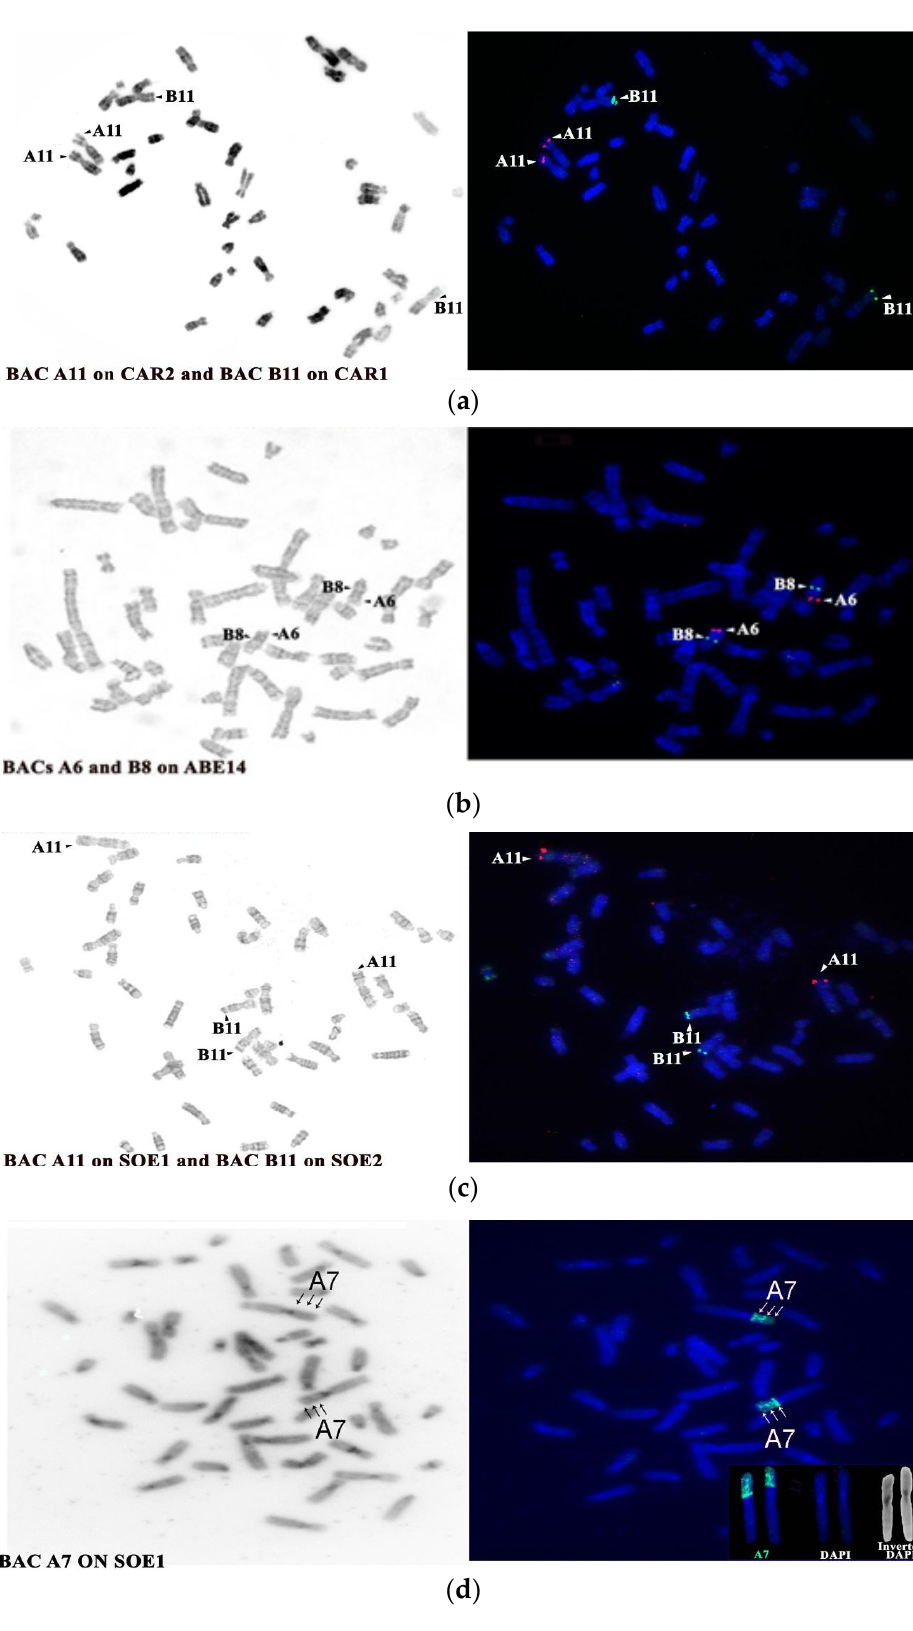
Figure 2. Examples of fluorescent in situ hybridisation of mapped BACs onto CAR ( a ), ABE ( b ), SOE ( c , d ) metaphases. Note that BAC A7 on SOE chr 1p (d) shows triple band signals.